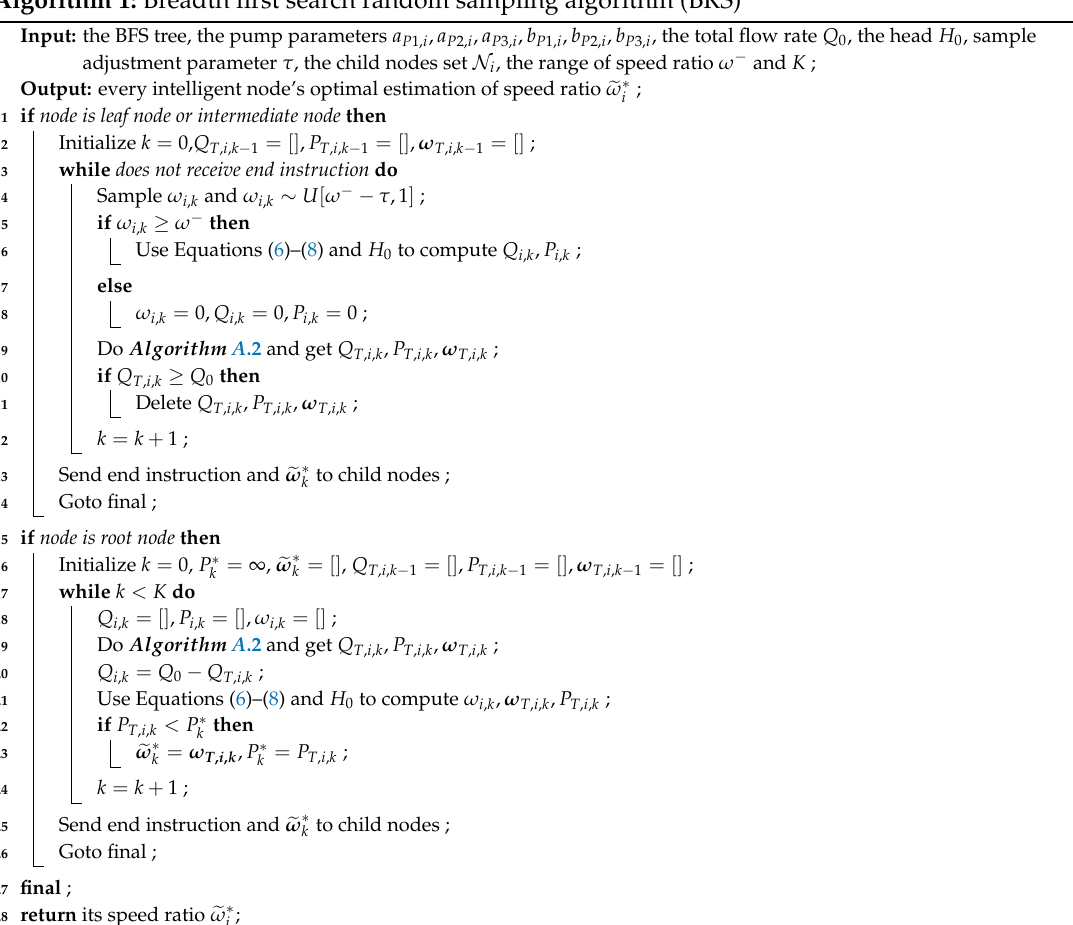
Algorithm 1: Breadth first search random sampling algorithm